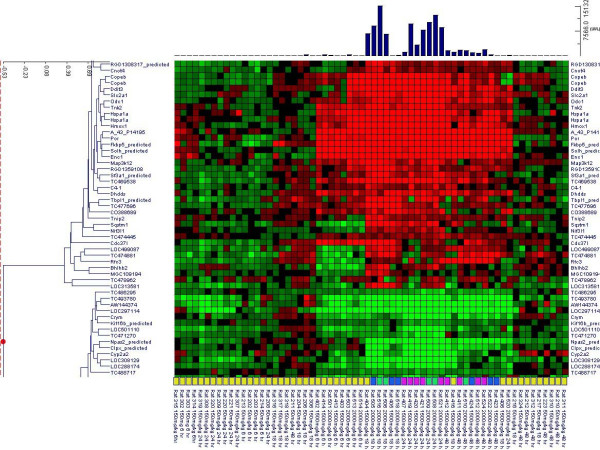
Two-way hierarchical clustering of the biological samples and the extracted genes. Log10 transformed gene expression ratio values of the 82 genes from the prototypes of the clusters of the biological samples were subjected to agglomerative hierarchical clustering as detailed in Figure 5. The resulting gene expression heat map contains the genes as the rows and samples as the columns with red indicating up regulation, green denoting down regulation and black signifying no change. At the top of the heat map, the level (UI/L) of ALT is plotted for each sample. At the bottom of the heat map, the severity of centrilobular necrosis observed is shown for each sample. (yellow, none; blue, minimal; magenta, mild; green, moderate).